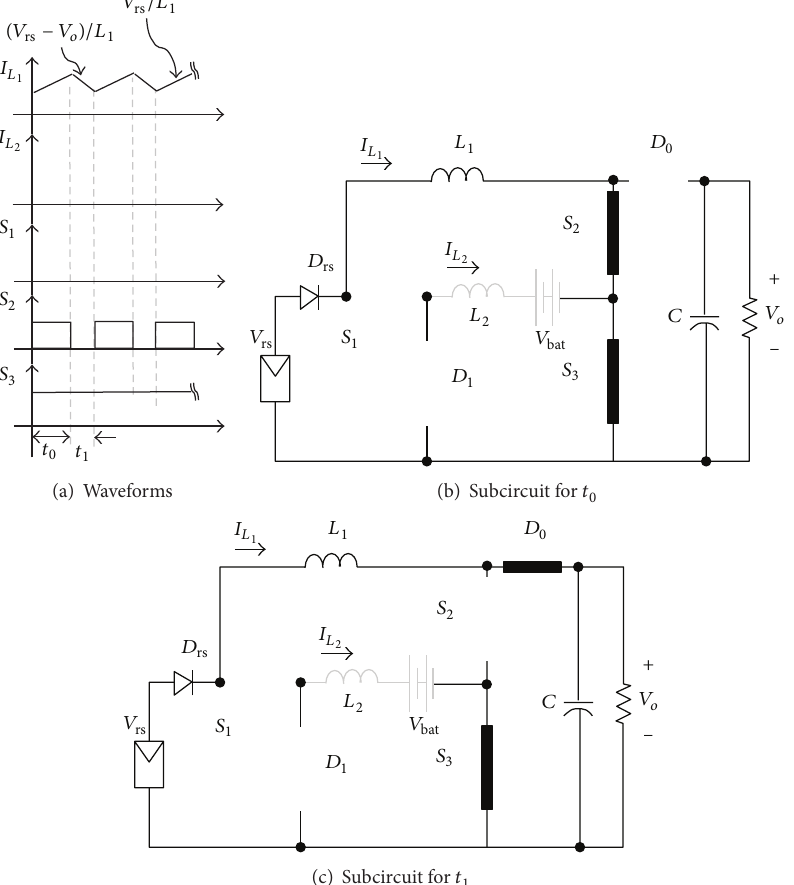
Figure 5: Waveforms and subcircuits when the energy is obtained from the renewable source (mode 1, no charging).